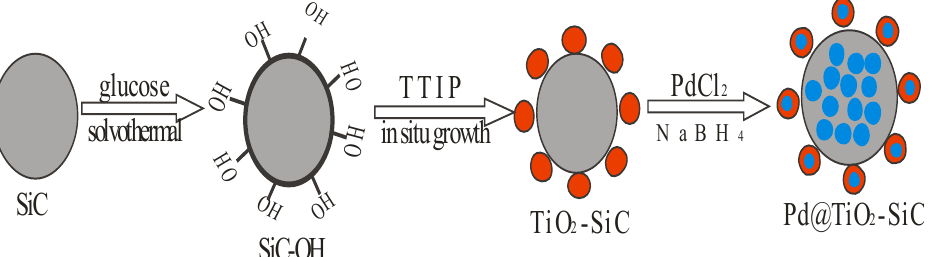
Figure 19. Design and synthesis of Pd@TiO2-SiC nanohybrids.